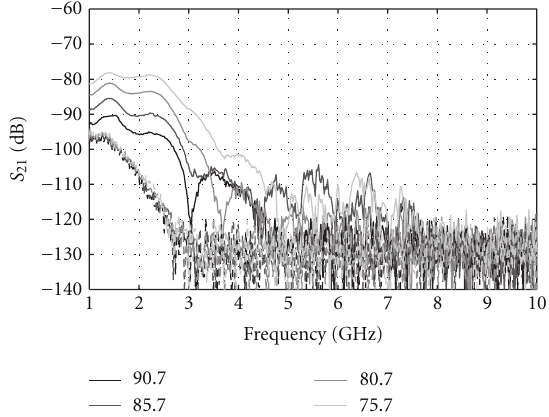
Figure 13: Transmission magnitude for the 55-year-old volunteer, left breast with di ff erent separation distances between the sensors. The dashed curves correspond to the transmission measured for the same distances but without the breast